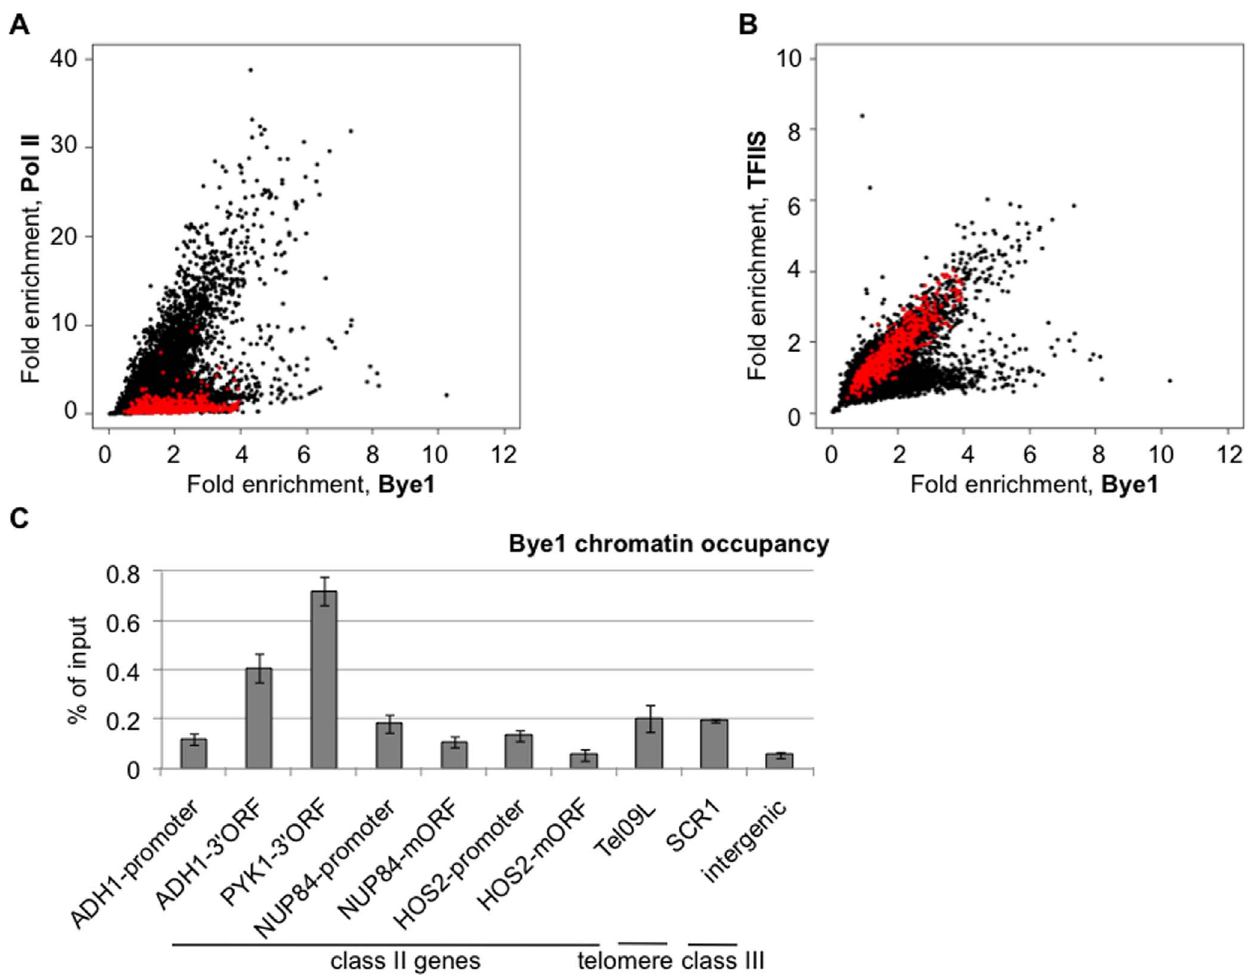
Figure 1. Analysis of Bye1, TFIIS and Pol II chromatin occupancies in yeast: (A, B) Genome-wide scatter-plots of Bye1 and Pol II distribution assessed by ChIP-chip in the Bye1-Myc HA-TFIIS strain. Comparison of fold enrichment ( A ) between Pol II and Bye1 and ( B ) between TFIIS and Bye1. Red dots correspond to probes complementary to class III genes (listed in Table S7); ( C ) Quantification of Bye1 enrichment in coding regions of class II and class III genes, promoters of some class II genes and Y’-containing telomeric ends by ChIP. 3 9 ORF and mORF stand for the 3 9 end and middle coding regions.